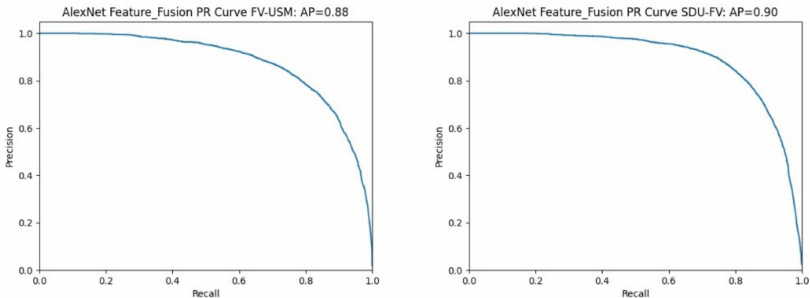
Figure 9. Fusion of identified P-R curves on the AlexNet feature extraction